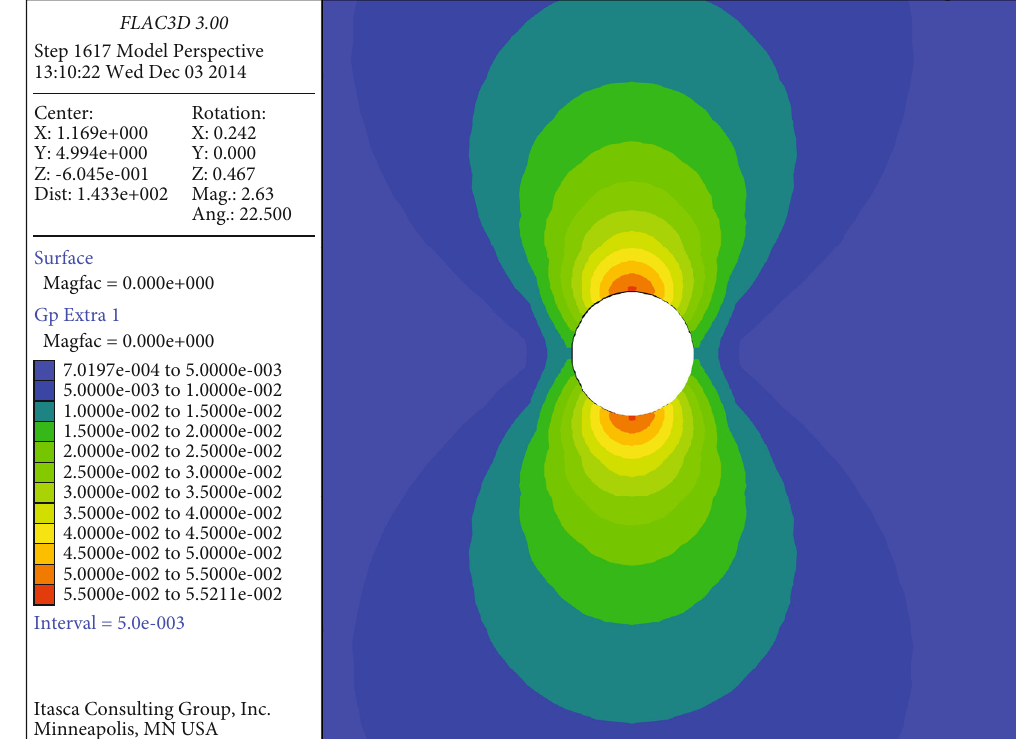
Figure 5: The radial displacement.